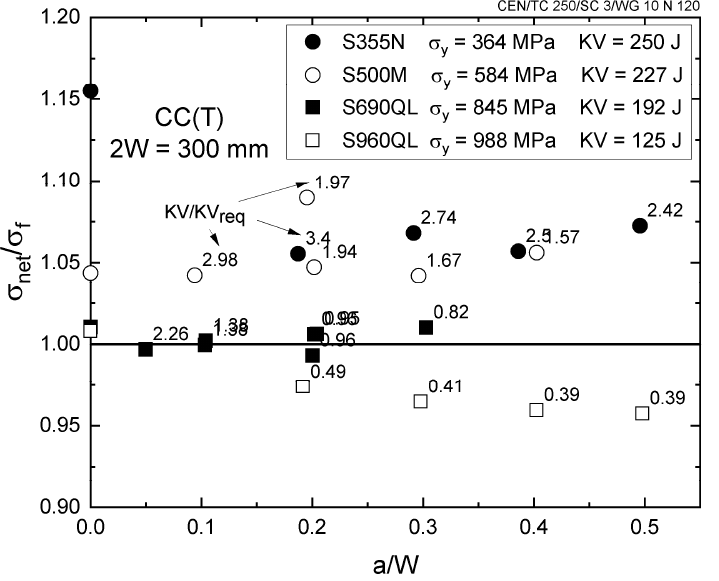
Figure 10. Net section stress values divided by flow stress for the data in Figure 7 as a function of relative crack length and related to the ratio between the Charpy-V impact energy and estimated required impact energy to obtain the plastic limit